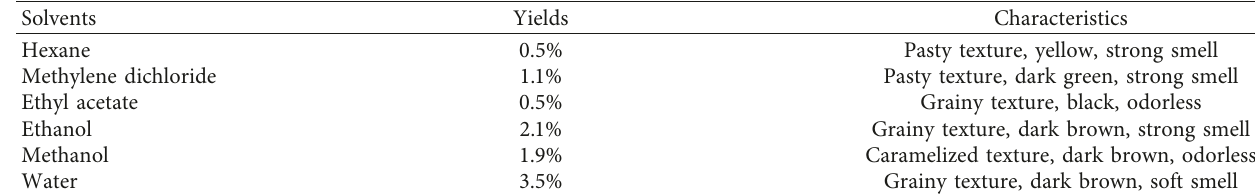
Table 1: Yield and characteristics of leave’s extracts with different